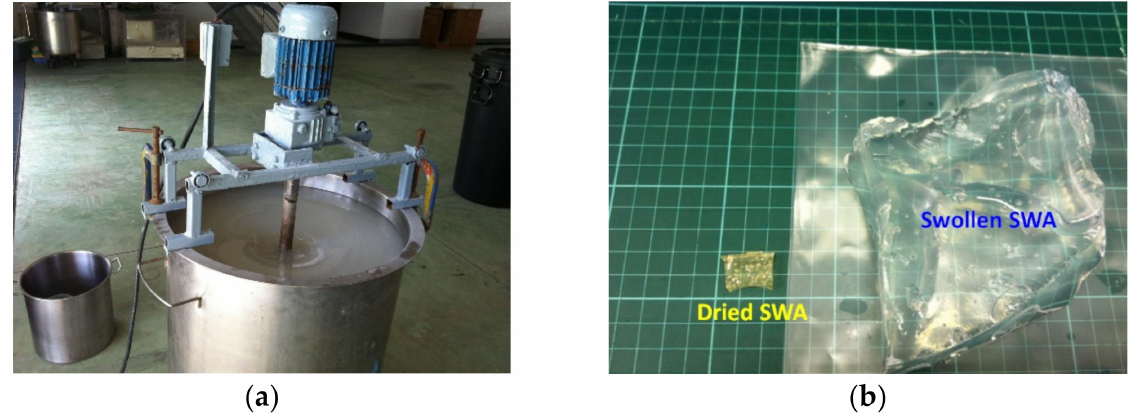
Figure 2. ( a ) A 150-L reactor used for up-scaling production of SWA; ( b ) Physical appearances of dried and swollen SWA.